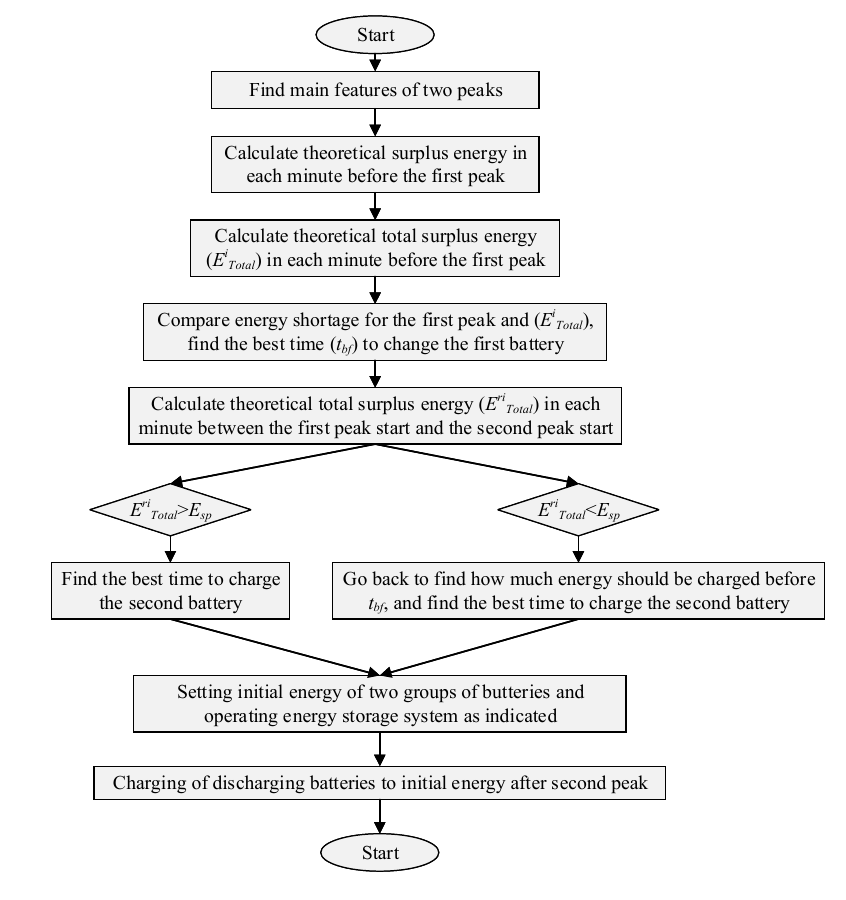
Figure 5. Electrical Energy control rule.